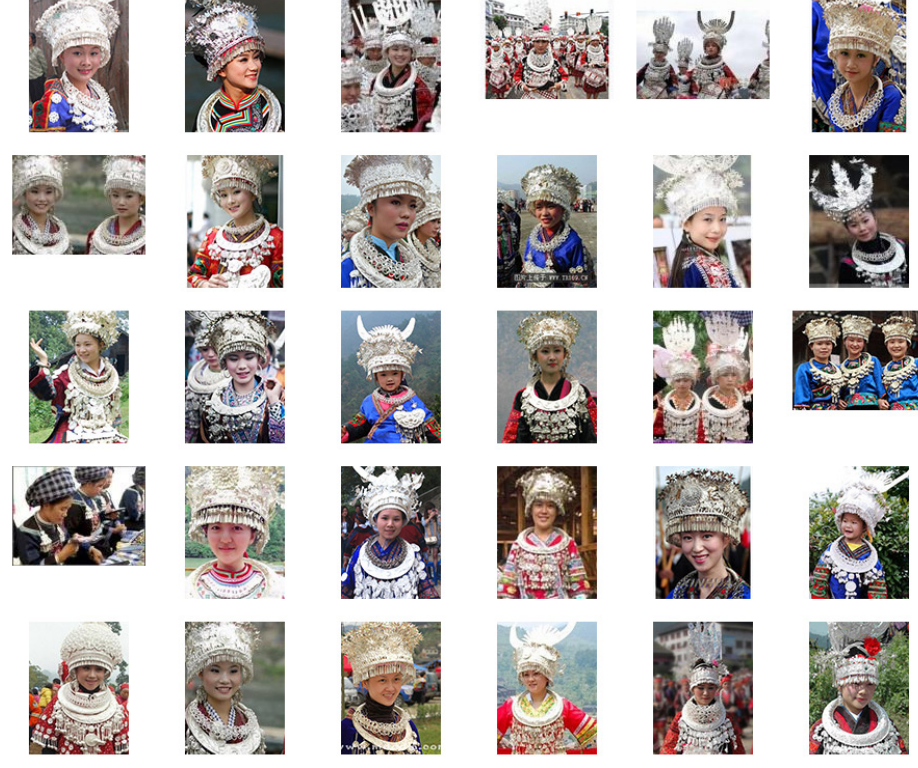
Fig.5. More results for query “Bai